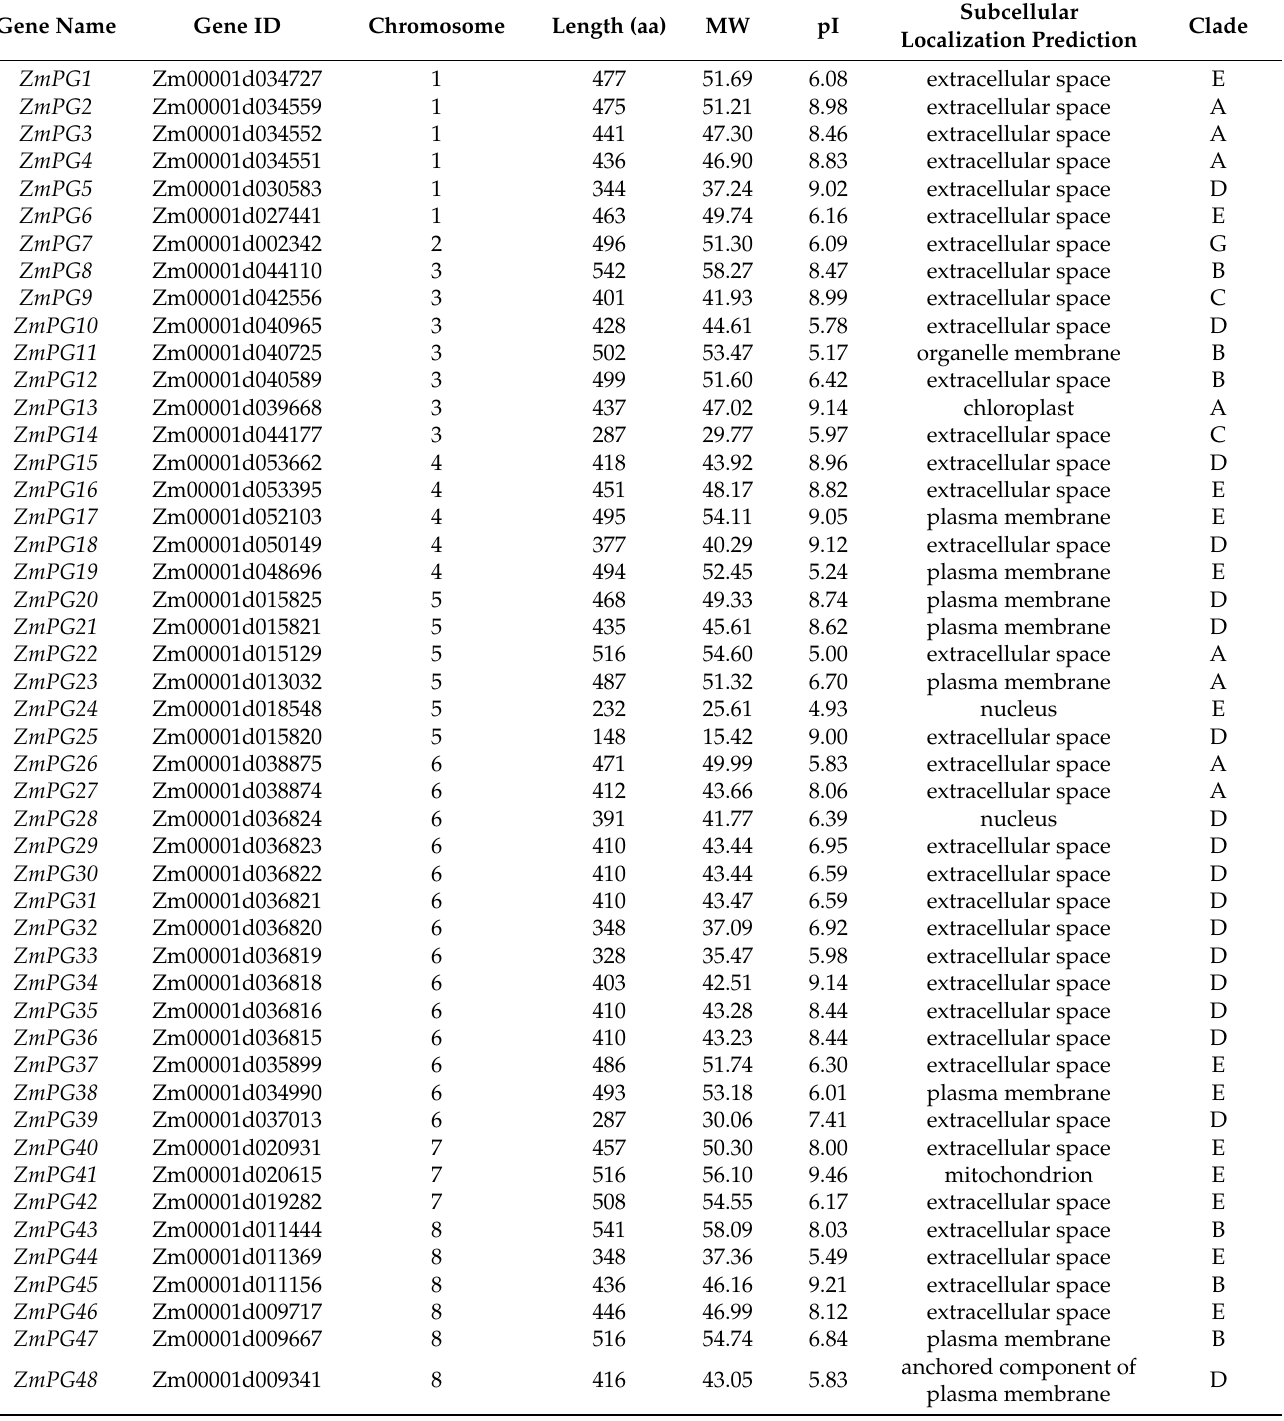
Table 1. The polygalacturonase ( PG ) gene family in